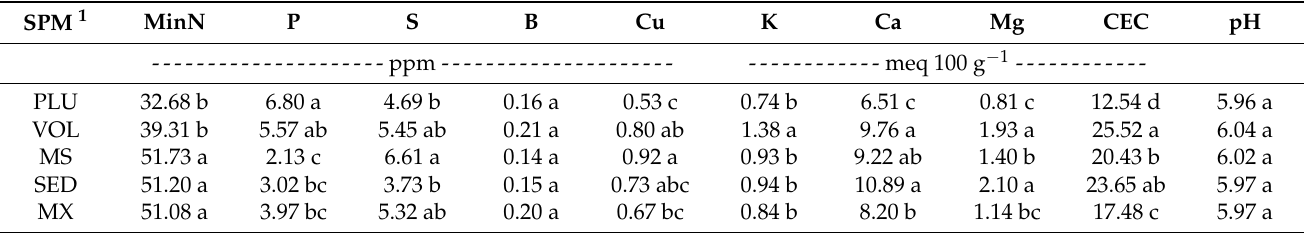
Table 3. Comparison of mean soil chemical characteristics among soil parent material types. Means followed by the same letters are not significantly different at the 90% confidence